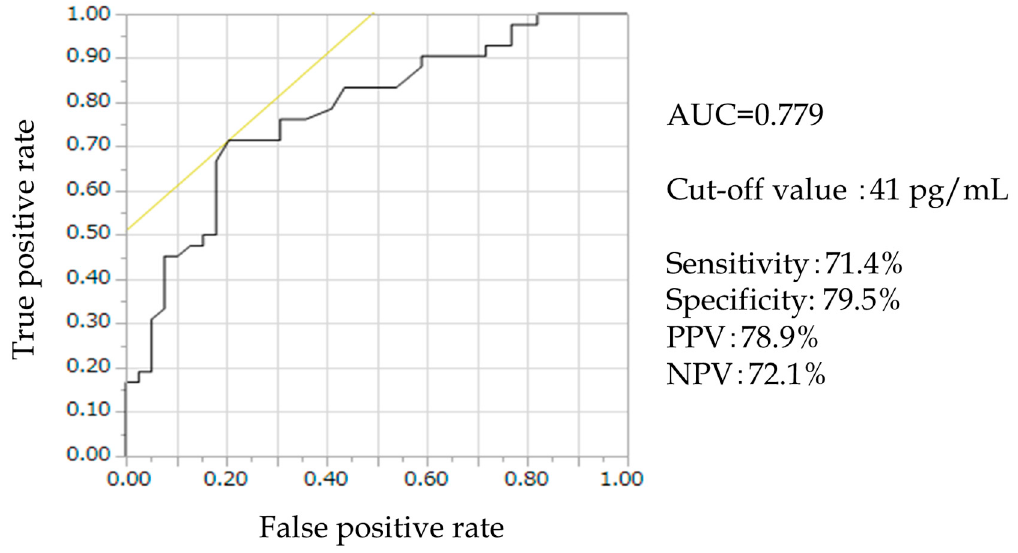
Figure 9. ROC curve of patients with satisfactory control of refractory ascites and corresponding renin concentration. AUC = 0.779; Cut-off value, 41 pg/mL; sensitivity, 71.4%; specificity, 79.5%; PPV, 78.9%; NPV, 72.1%. AUC, area under the curve; NPV, negative predictive value; PPV, positive predictive value; ROC, receiver operating characteristic. Table 4. Relationship between hepatic ascites control 3 months after RFX administration and renin concentration ( n = 81). Renin Levels Satisfactory Control Poor